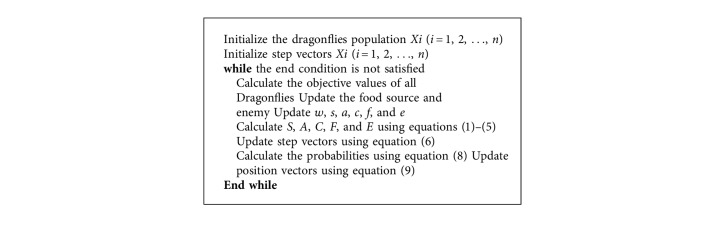
Pseudocode for BDA [9].